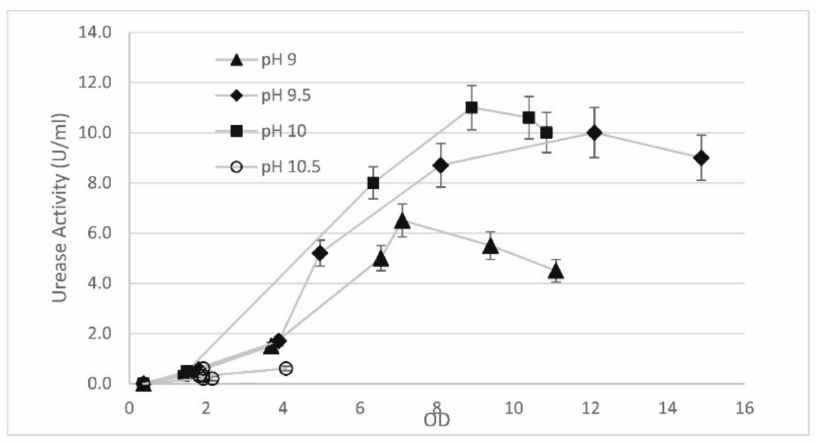
Figure 15. Relationship between urease activity and bacterial concentration under different initial pH mediums